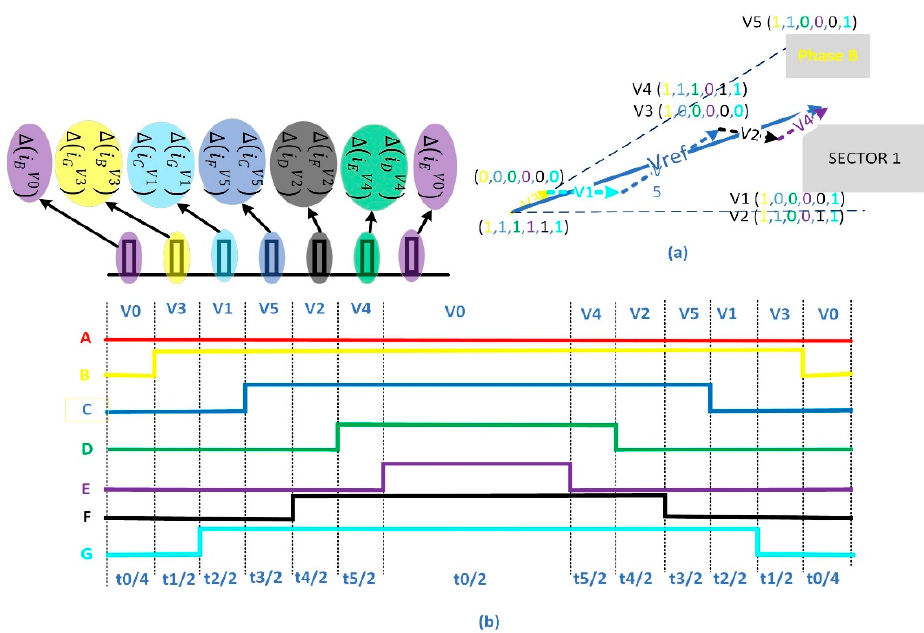
Figure 14. Active switching sequence and the associated PWM waveform of the seven-phase drive after losing phase ‘A’ when V_ref exists in the first sector. ( a ) active switching sequence. ( b ) sampling instants.